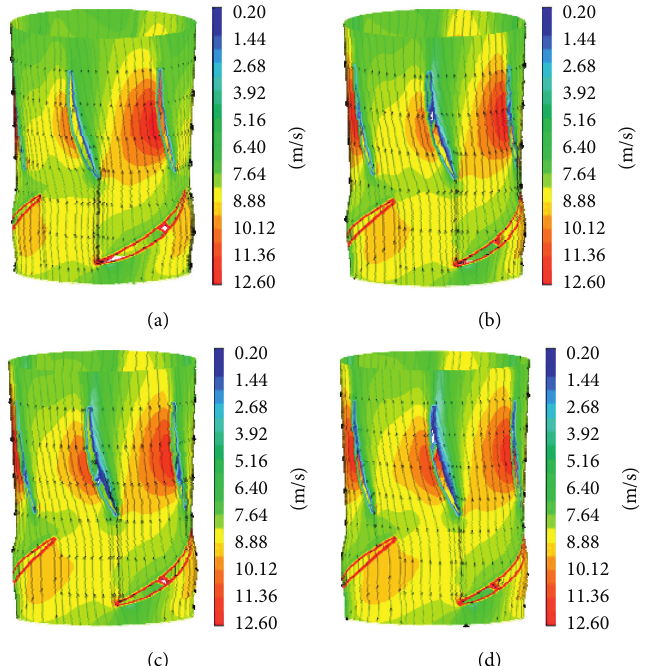
Figure 15: Flow fields of middle tori of the pump segment at different time in one period T ( Δ β � 0 ° ). (a) t � 1/4 T , (b) t � 2/4 T , (c) t � 3/4 T , and (d) t � T